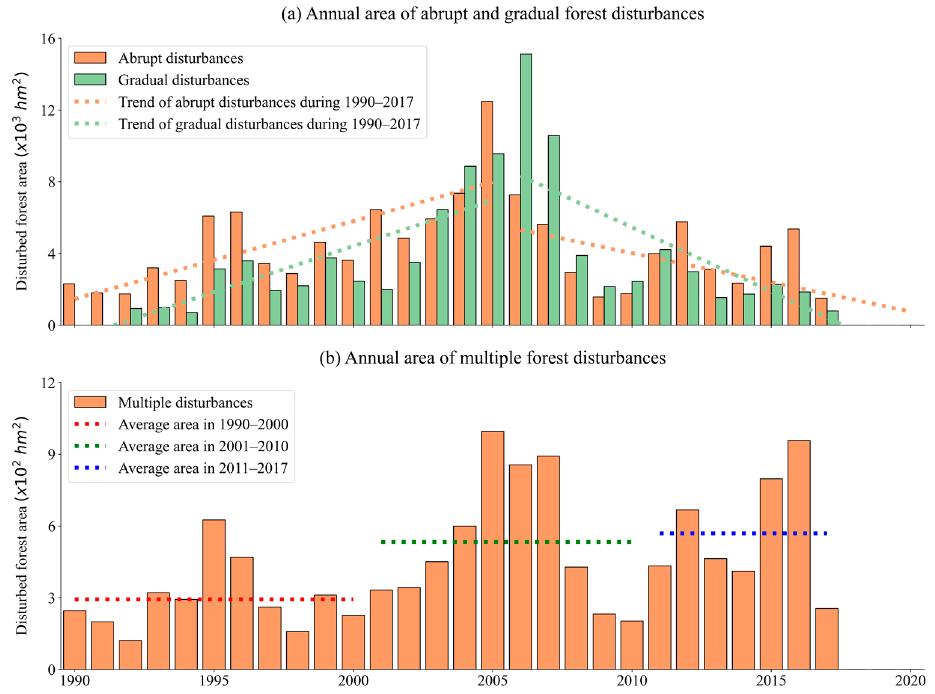
Figure 9. Interannual variation characteristics of forest disturbance: ( a ) abrupt and gradual disturbances, and ( b ) multiple disturbances.